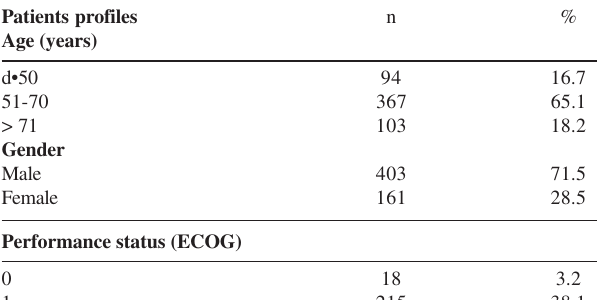
Table 1 – Basic characteristics of patients.